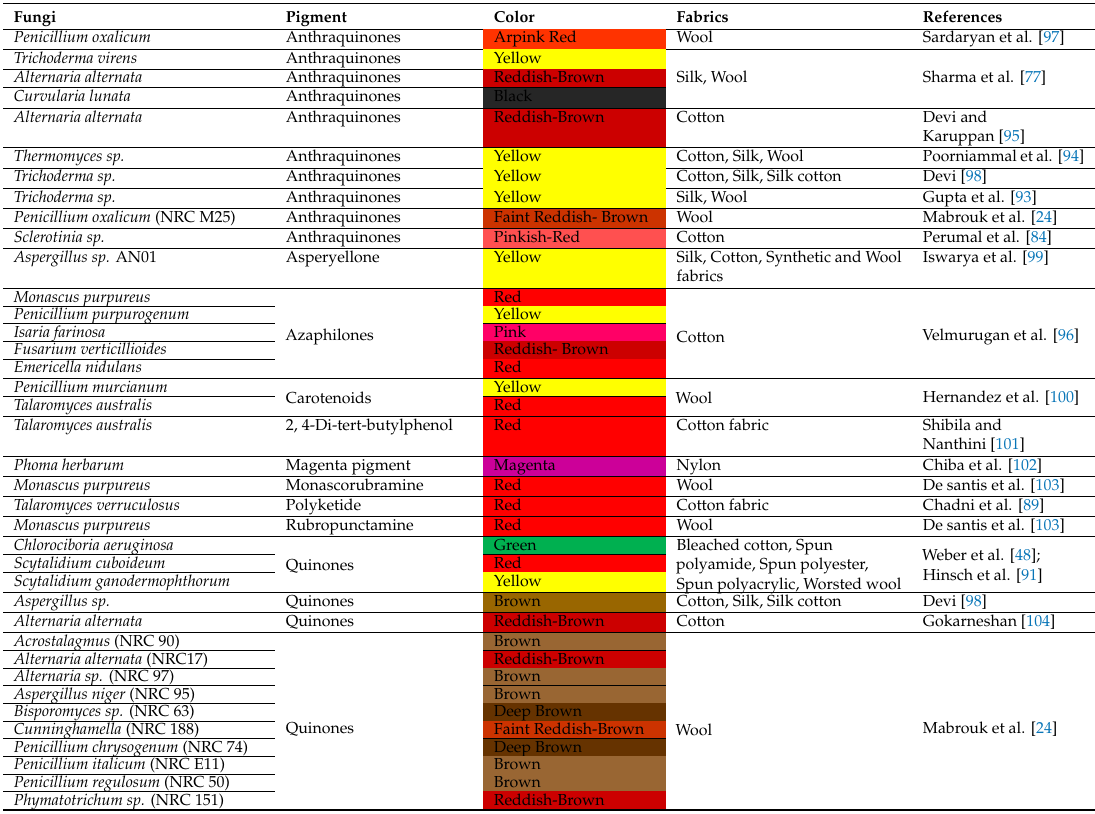
Table 1. Fungal pigments and their application in the textile